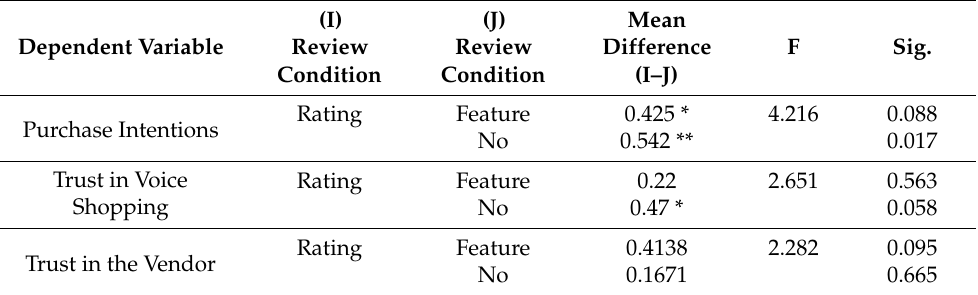
Table 2. Tukey’s Post hoc Test Results for the Review Conditions by Rating and